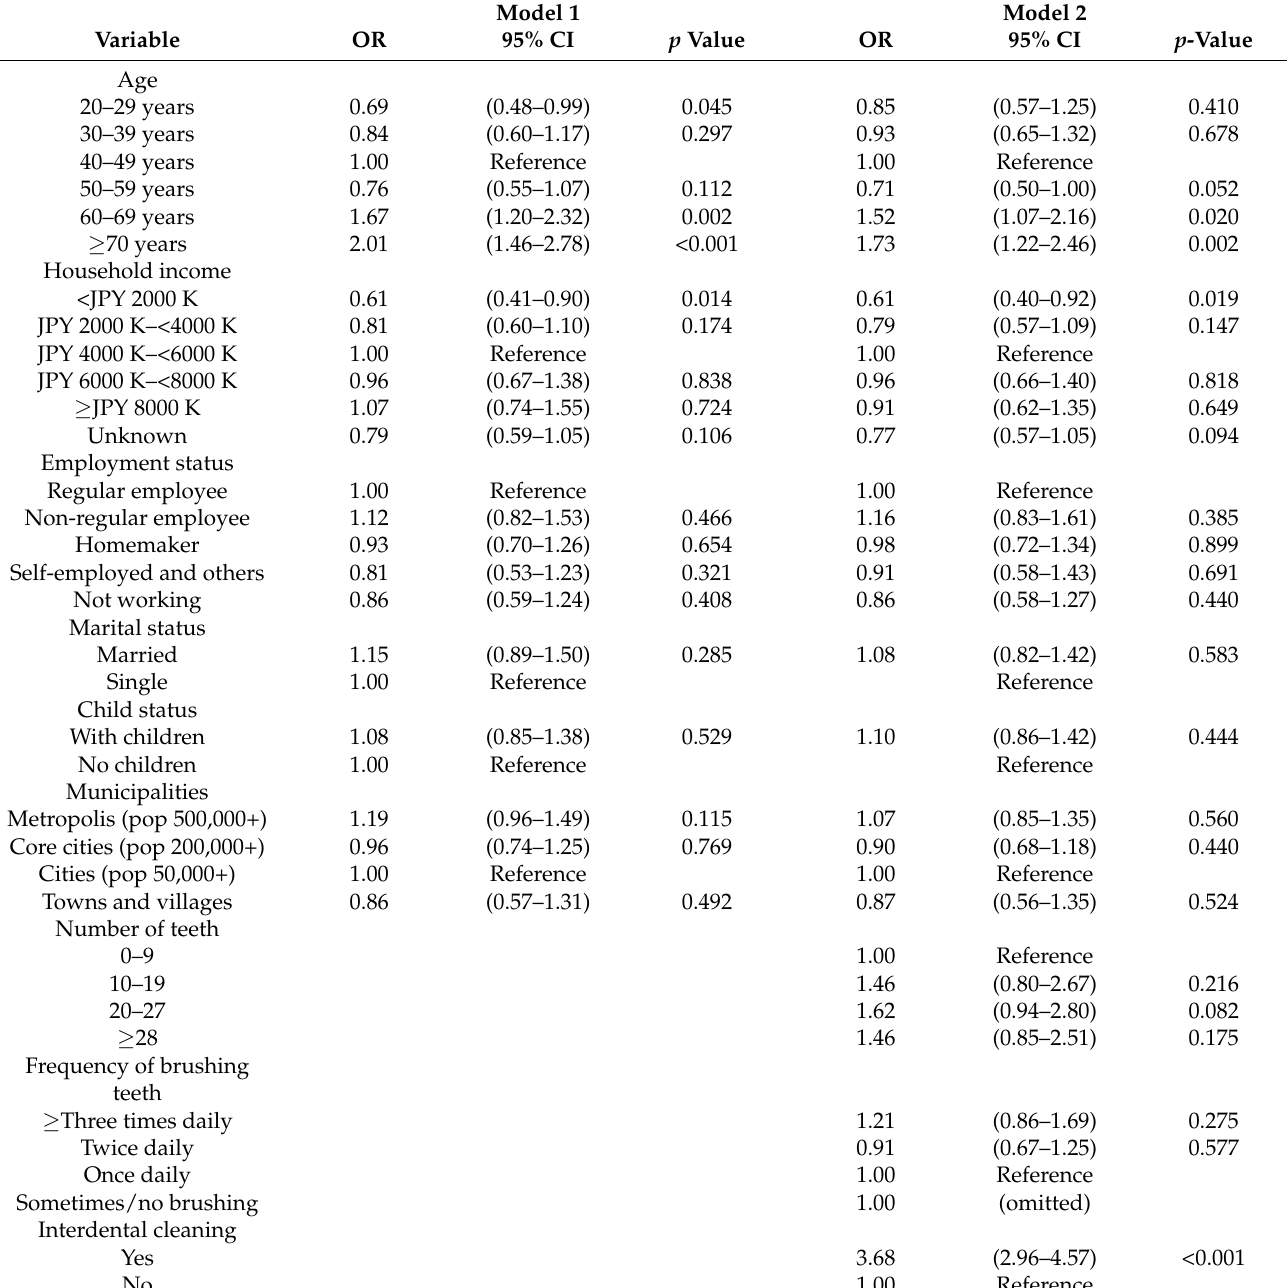
Table 4. Characteristics of the female participants in the FD